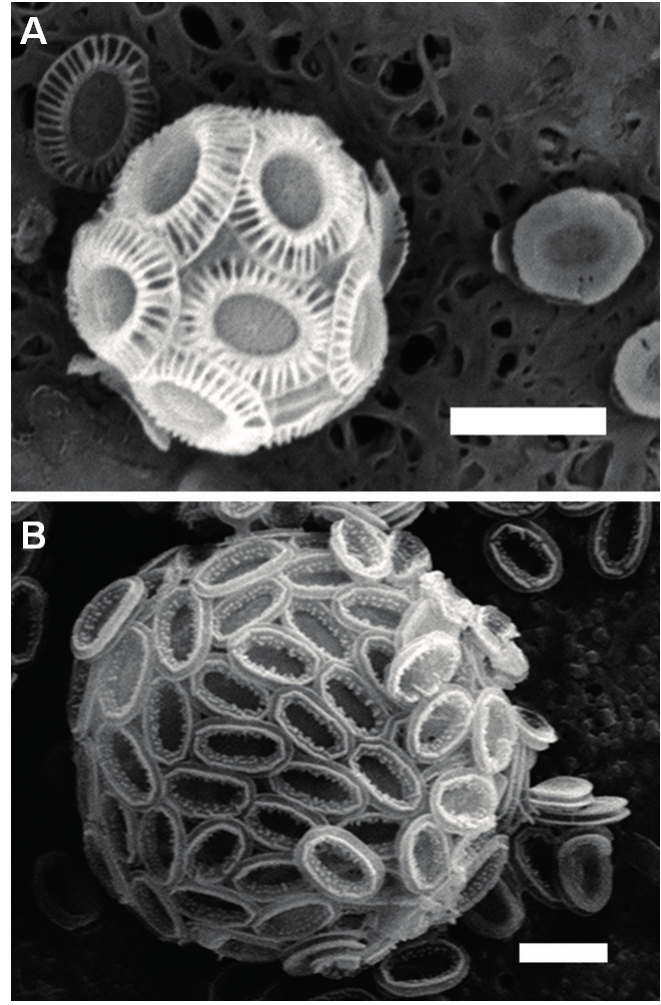
Figure 1. Scanning electron microscopyimages of typical morphology features of coccolithophores. ( A ) Image of a whole cell of E. huxleyi ; ( B ) Image of a whole cell of P. carterae . The complete coccoliths in distal shield and proximal shield views are also presented in ( A ). Scale bars: 2 μ